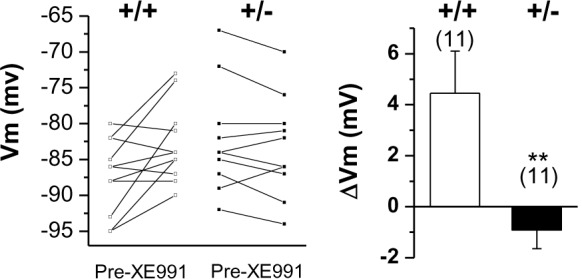
Changes in membrane potential in WT (+/+) and Prmt1+/- GCs (+/-) in response to 10 μM XE991.Each connected line represents an individual neuron. Right panel gives the averaged changes. XE991 was less effective in mutants than in WT.DOI:
http://dx.doi.org/10.7554/eLife.17159.00910.7554/eLife.17159.010Figure 3—figure supplement 1—source data 1.Source data for Figure 3—figure supplement 1.